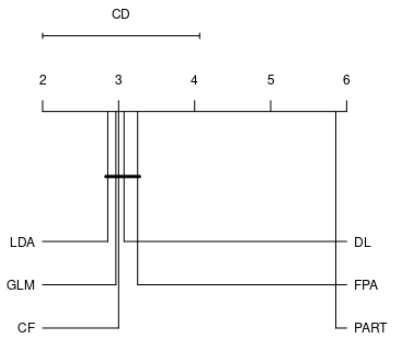
Figure 8. Critical difference plot of selected classifiers in terms of 10ho.